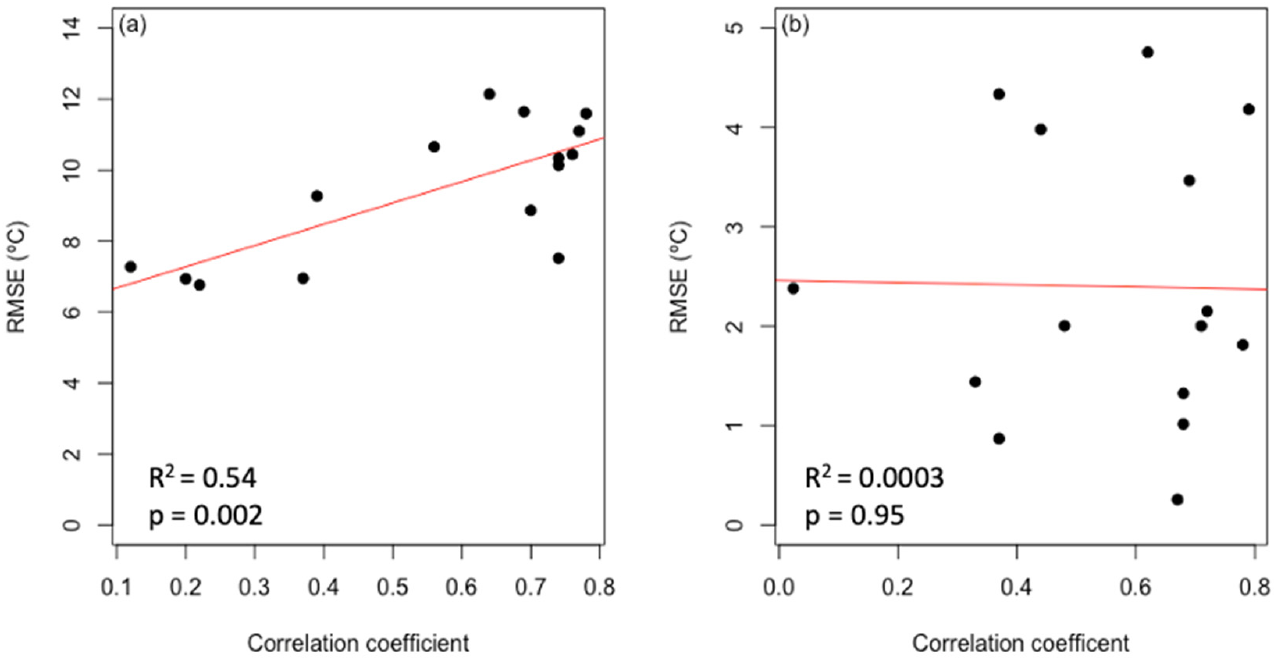
Figure 5. RMSE plotted against correlation coefficient for ( a ) the relationship between LST anom and 11:30 a.m. T air(anom) and ( b ) the relationship between 11:30 p.m. T air(anom) and 11:30 a.m. T air(anom).